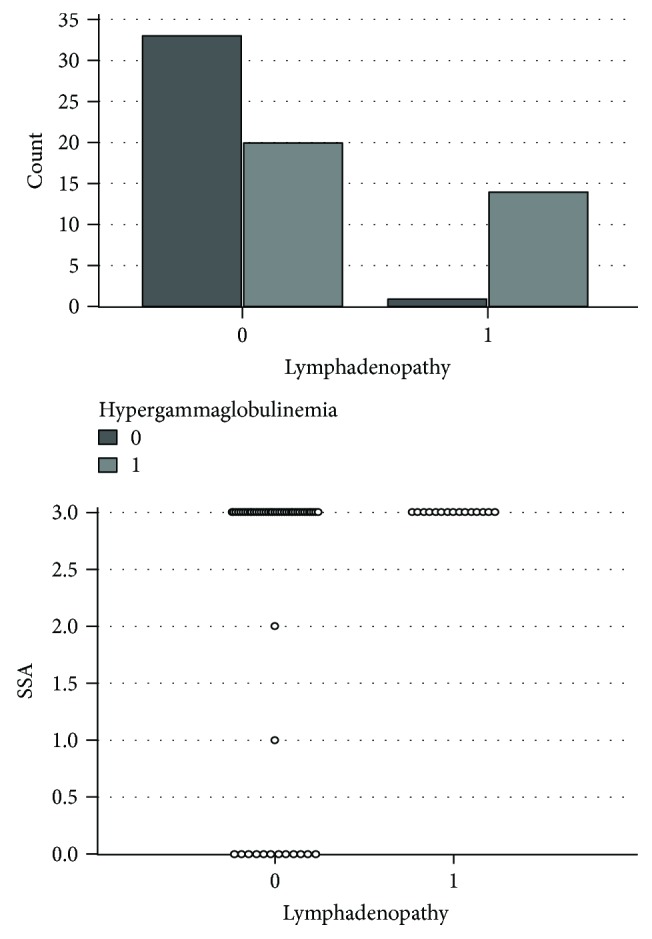
Lymphadenopathy rate in patients with hypergammaglobulinemia and its correlation with anti-SSA antibodies.